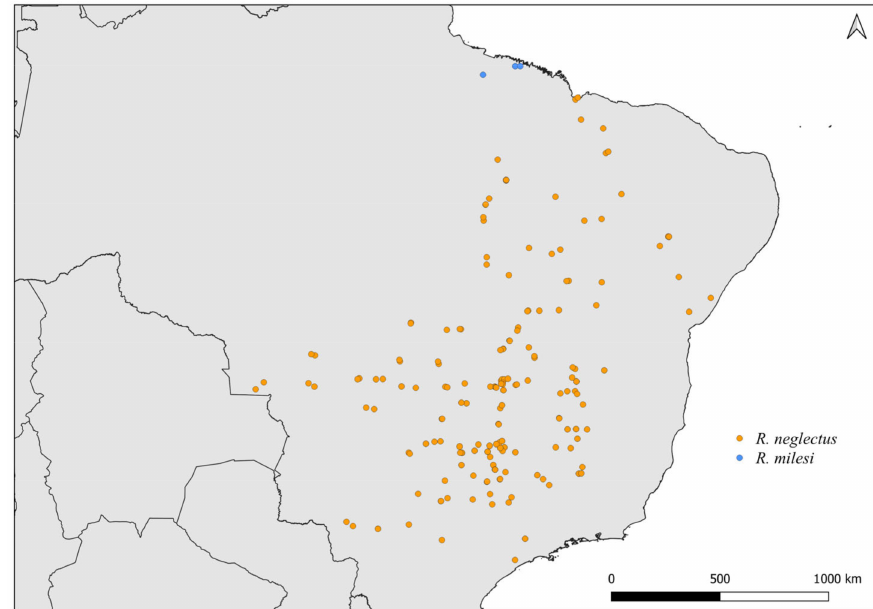
Figure 7. Distribution maps for R. neglectus and R. milesi .